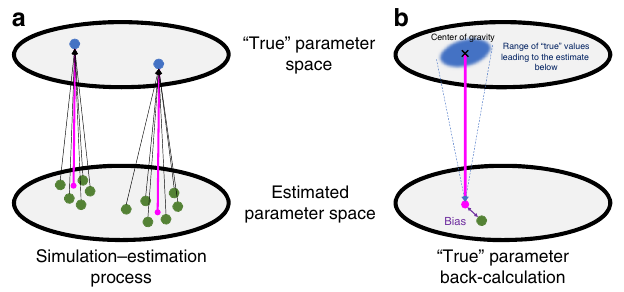
Fig. 1 Schematic illustration of the simulation – estimation and parameter back-calculation. Schematic of a the simulation – estimation procedure and b back-calculation of the “ true ” parameter range that can produce the estimated values. Points in blue are the “ true ” parameter values used in the simulation (summarized here in a theoretical 2D surface). Points in green are the estimated parameter values (maximum likelihood estimate) when model are fi tted to data generated from the corresponding simulation scenario (i.e., the blue points where the black arrows point towards in a ). The magenta line with the magenta point in a shows the location of the unbiased parameters estimates. Any difference between the magenta and green points suggest parameter bias. In panel b , the shaded blue area in the “ true ” parameter space shows the range of estimated “ true ” parameter values that could have led to the green point in the estimated parameter space based on the simulation – estimation results from a . Additionally, in panel b , X points at the center of gravity of the “ true ” parameter space, the magenta point is the corresponding projection in the estimated parameter space, and the purple arrow shows the average